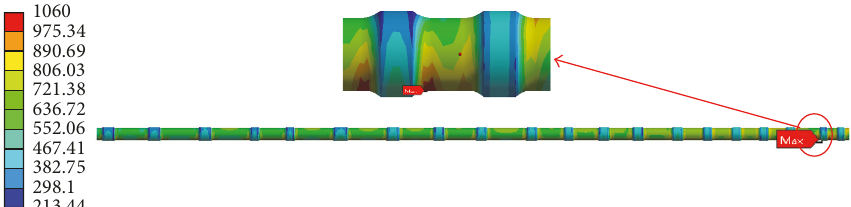
Figure 18: Equivalent stress distribution of the compressor tie rod at time of 970